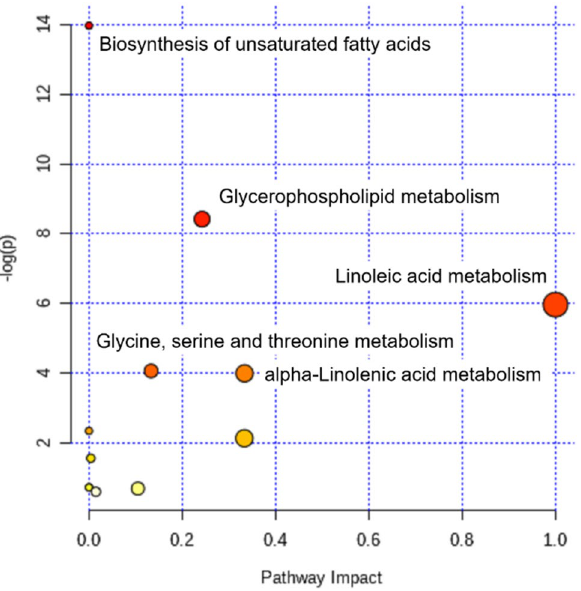
Figure 3. Pathway mapping with MetaboAnalyst, based on changes in metabolites, without adjustments for multiple testing and with p < 0.05. The Y-axis is the –log p values from the pathway enrichment analysis. The X-axis is the pathway impact values, from pathway topology analysis. The node colors and radii are based on p values and pathway impact values, respectively. Color intensities increase with reducing p values, and the sizes of the circles increase with increased pathway